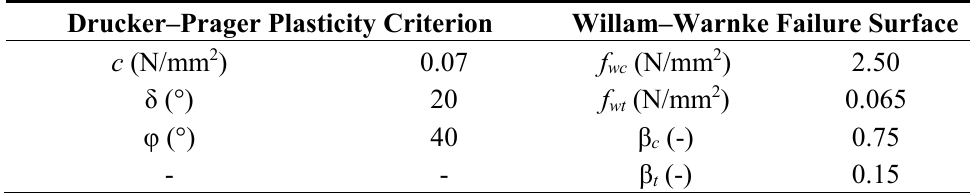
Table 1. Finite element (FE) model parameters ( f wc = masonry compressive strength; f wt = masonry tensile strength; β c = shear transfer coefficient for closed cracks; β t = shear transfer coefficient for open cracks; c = cohesion; δ = dilatancy angle; φ = internal friction